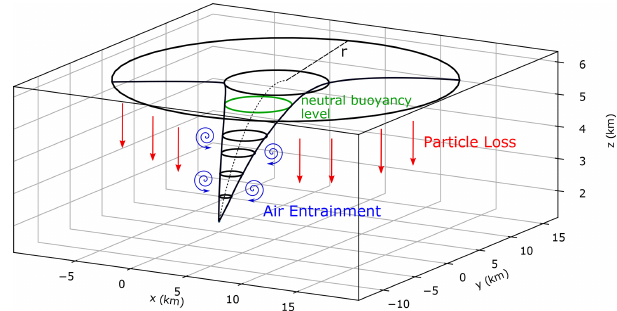
Figure 3. Schematic view of the plume. The dashed line represents the centerline of the plume. The horizontal circles indicate the sec- tions over which plume variables are averaged. The green circle rep- resents the plume section at the neutral boundary